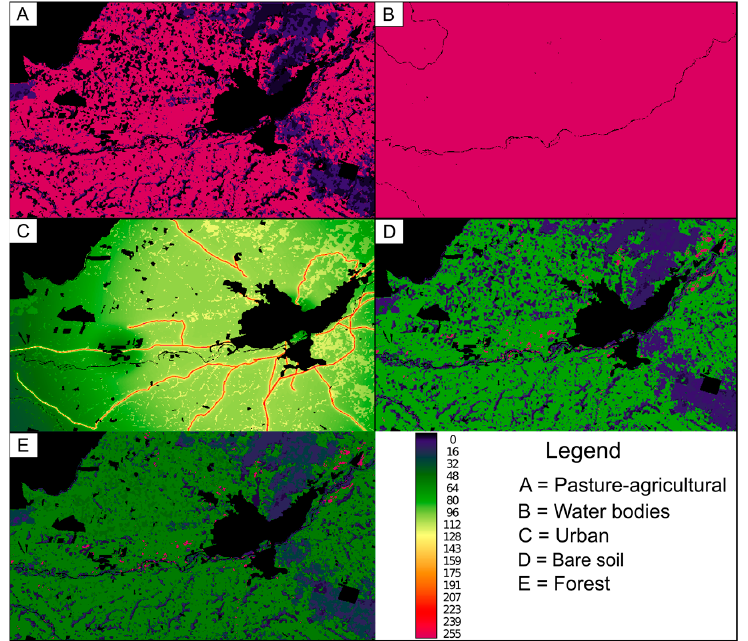
Figure 4. Suitability maps based on multi-criteria evaluation. Source: Authors’ compilation.